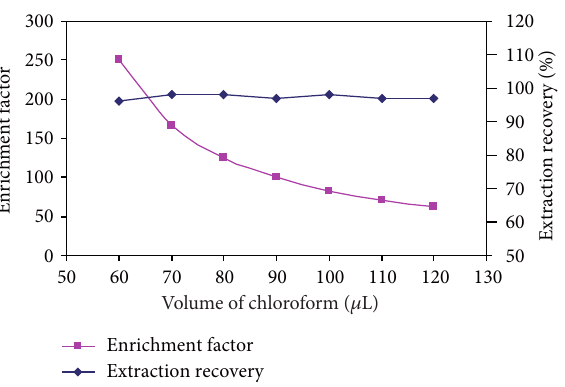
Extraction recovery F 4: Effect of the salt on the enrichment factor and extraction recovery of palladium obtained from DLLME. Extraction condi- tions: water sample volume, 5.0mL; disperser solvent